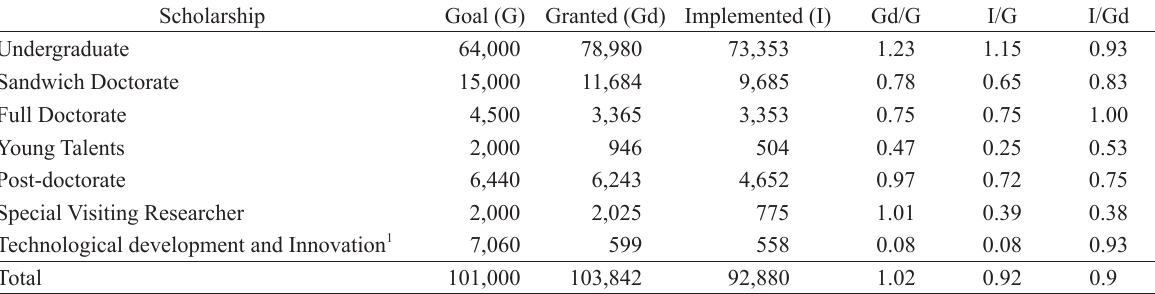
original goals and number implemented by type of